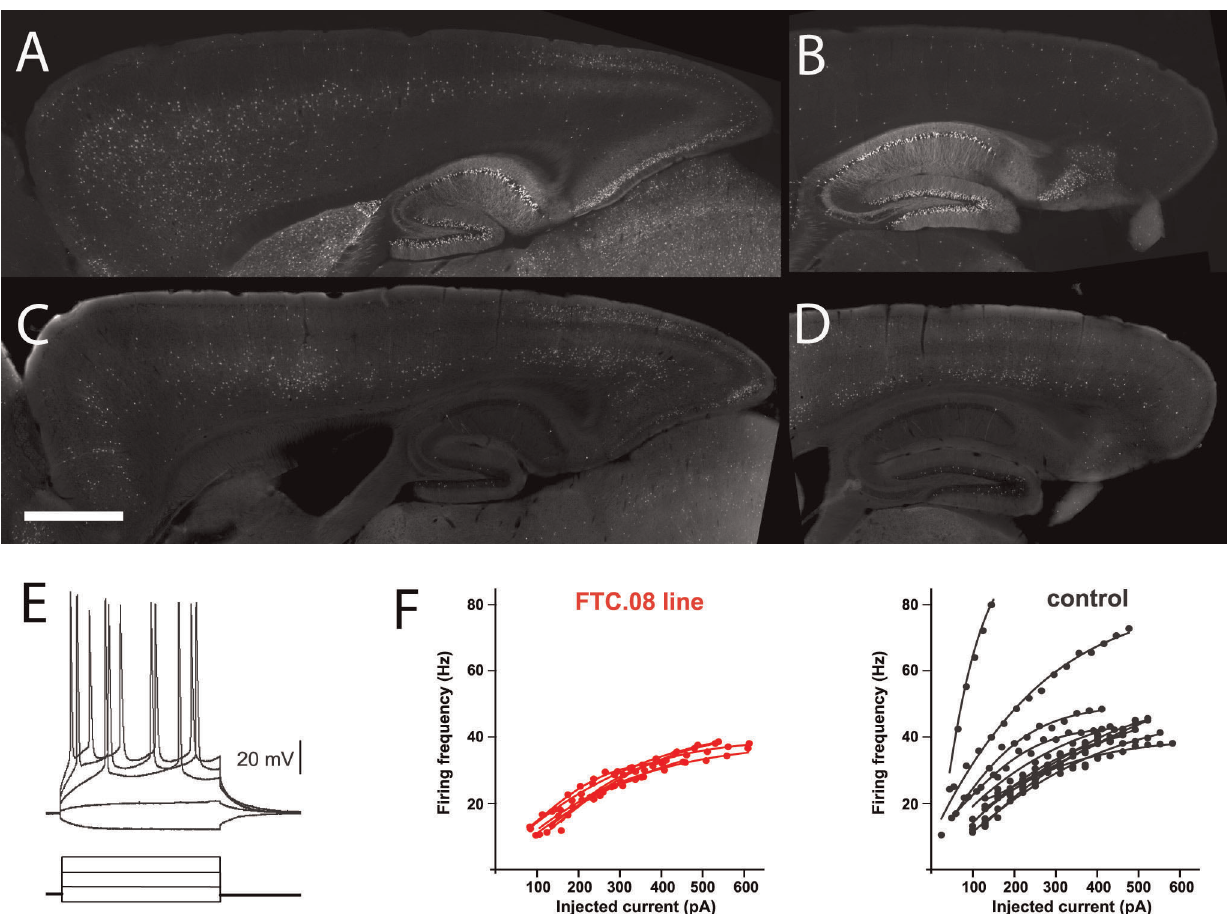
Figure 5. Variability of functional properties in neuronal subsets in thy1mp-cre lines. (A)-(D) Sagittal sections of thy1mp-cre lines (FTC.13 ((A), (B)) and FTC.08 ((C), (D)) reveal changes in the layer-specific expression in the frontal versus occipital cortical areas. In addition, in the occipital cortex the layer-specific expression changed from medial ((A), (C) corresponding to retrosplenial cortex) to lateral ((B), (D) corresponding to visual cortex) (bar=1 mm). (E) Whole-cell recordings from visual cortex layer 2/3 of thy1mp-cre line FTC.08 were performed from GFP positive and GFP negative neurons in the same animals (n=7 and 11, respectively). The relationship between the amount of injected current and the frequency of induced action potential was plotted for each recorded cell. GFP positive layer 2/3 neurons from FTC.08 had a smaller variability in their frequency- current relationship than GFP negative layer 2/3 pyramidal neurons in the same animals. (F) shows the adaptation index for GFP positive and GFP negative control layer 2/3 pyramidal neurons from line FTC.08 (n=7, 11, respectively). The adaptation index indicates the ratio of the second interspike interval (ISI) over the last ISI of a series of pulses (200 ms).